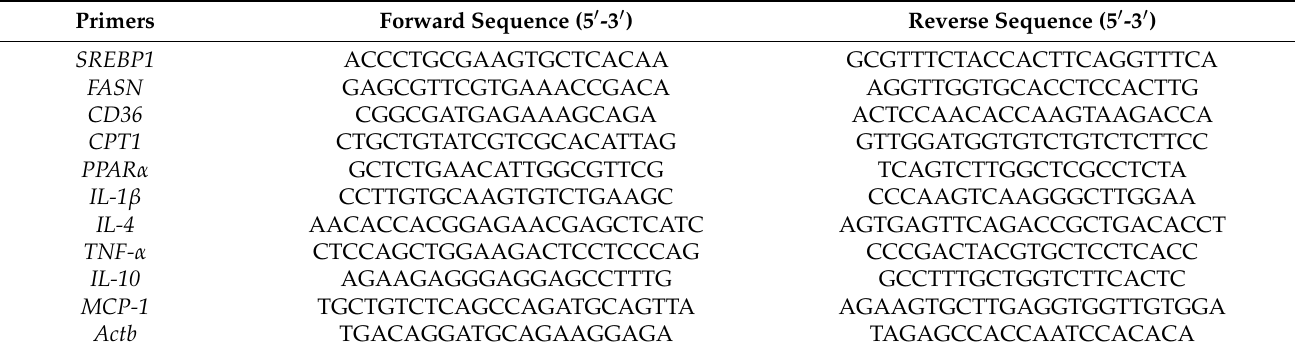
Table 1. The primer sequences for the targeted